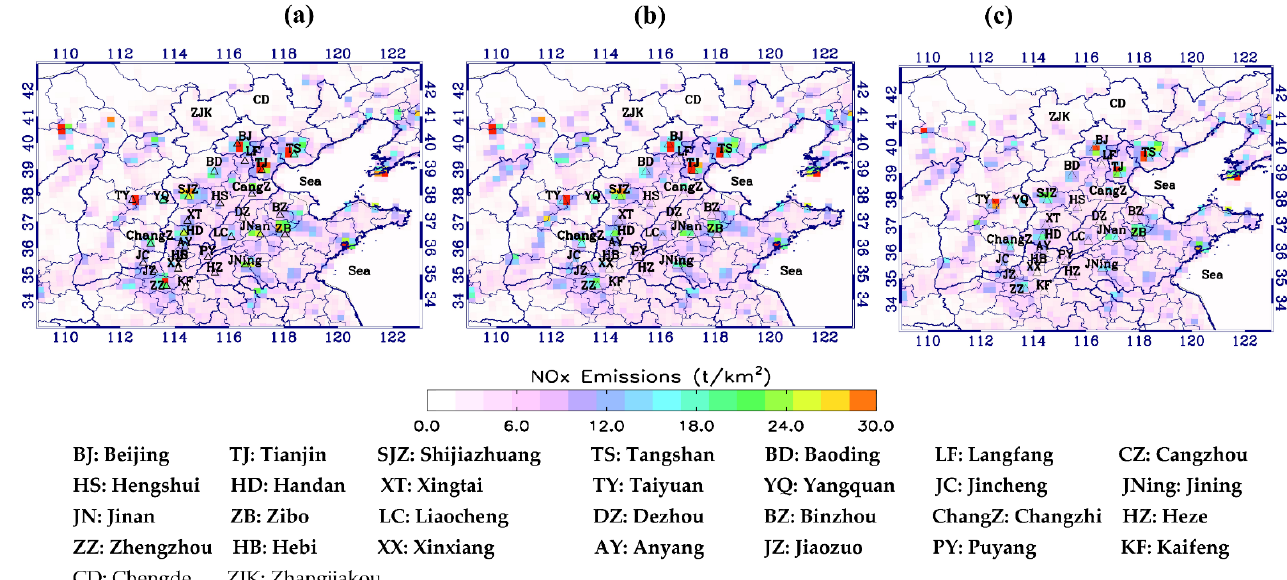
Figure 1. Four-month averaged nitrogen oxide (NO X ) emissions for ( a ) the multi-resolution emission inventory for China in 2017 (MEIC-2017), ( b ) top-down 1 November 2018 to 28 February 2019 (W_2018), and ( c ) top-down 1 November 2019 to 29 February 2020 (W_2019). ( a ) is four-month average for January, February, November, and December. ‘Four-month averaged’ in this paper refers to average of four months as indicated above, while the supplementary material is average of each month.